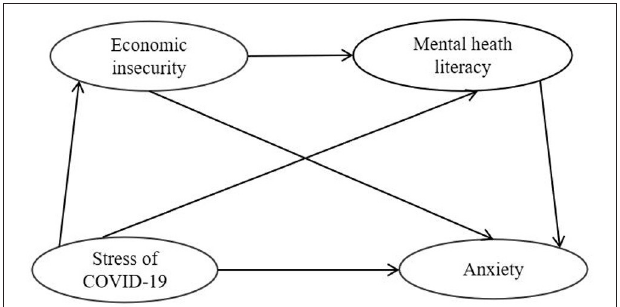
FIGURE 1 | Model of the hypothesized mediating roles of EI and MHL in the relationship between stress of COVID-19 and anxiety.